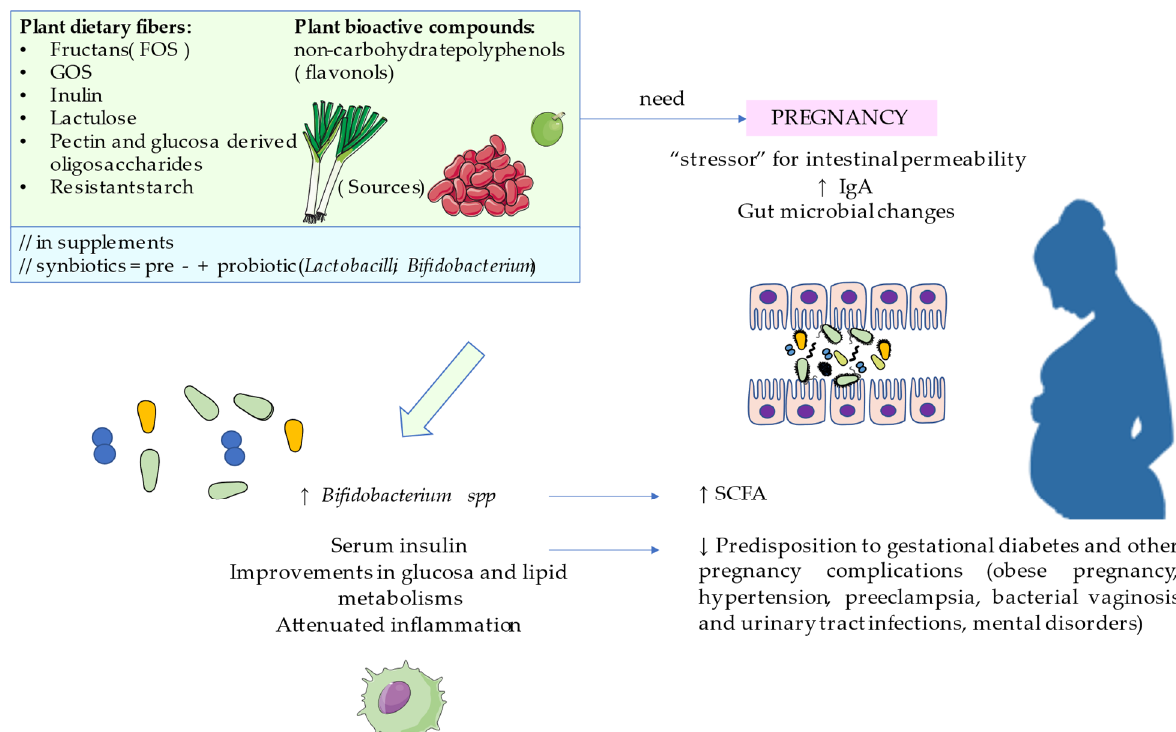
Figure 1. The effect of prebiotics on pregnancy.